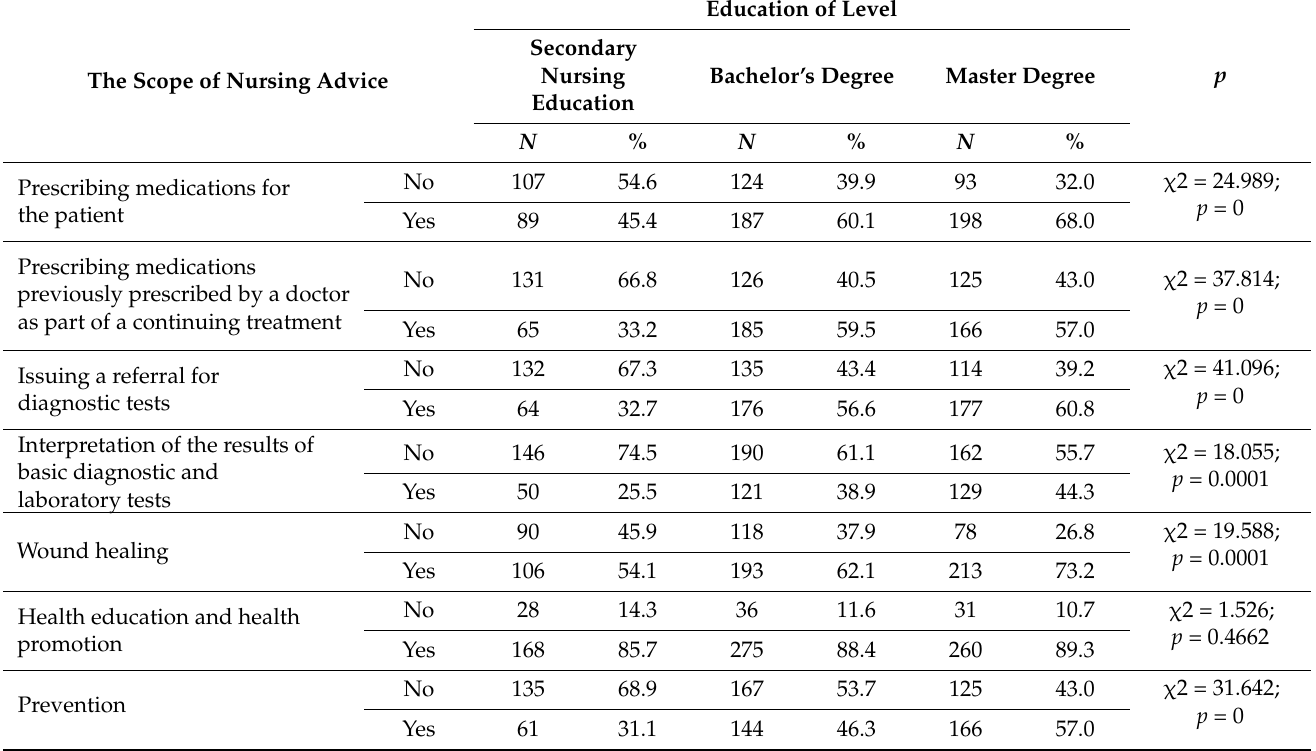
Table 5. The scope of nursing advice depending on the level of education of the surveyed nurses.